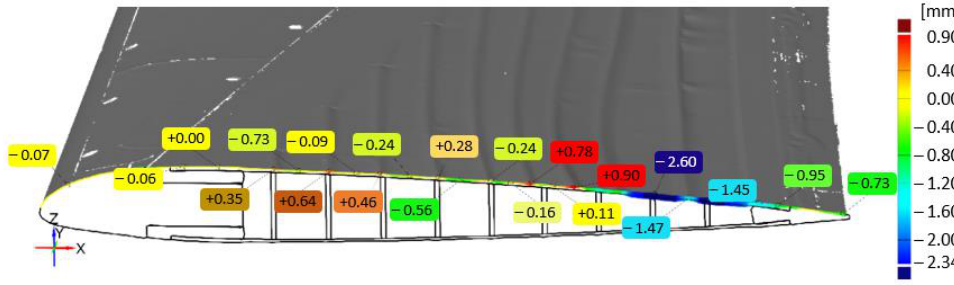
Figure 11. Surface comparison between simulation and experiment in a sectional view, 100 mm from the EPDM edge. Positive values stand for measured surfaces higher than the simulation; negative values indicate a measurement that is below the expectation of the simulation.